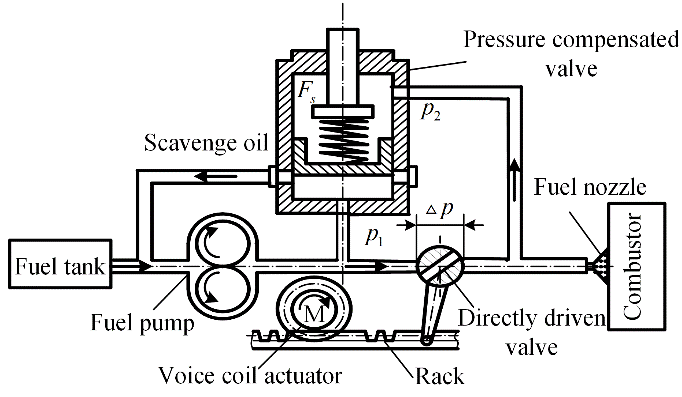
Figure 4. Flowrate control system with DDV driven by